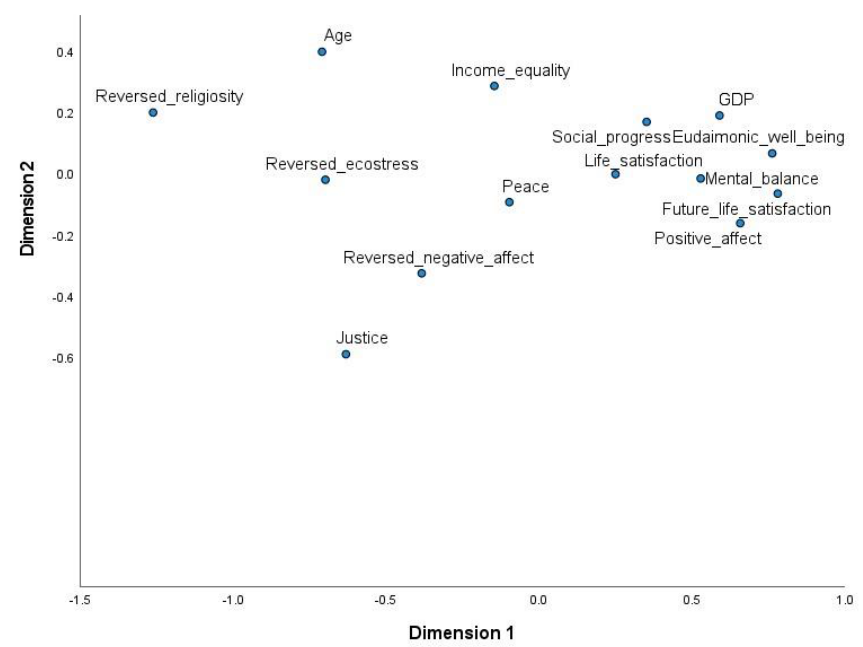
Figure 5. Multidimensional scaling plot.